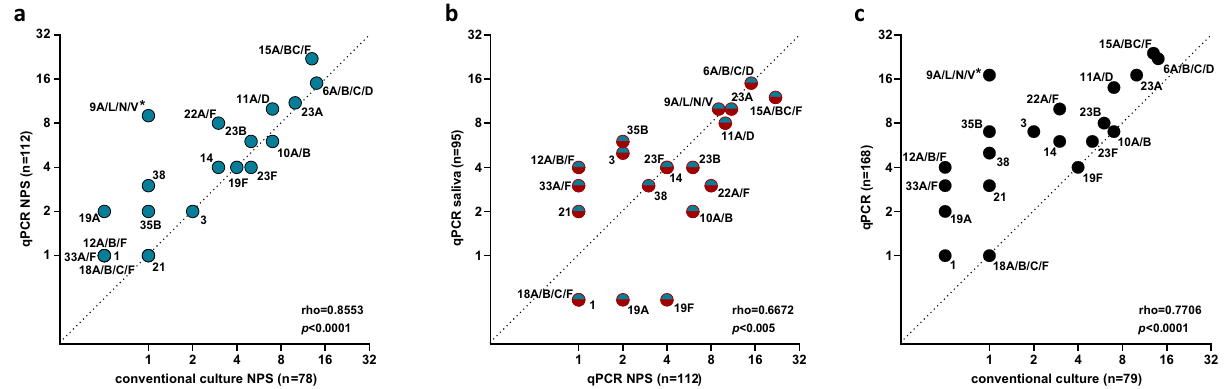
Figure 2. Scatter plot of results of pneumococcal serotypes detected by conventional culture and molecular method (qPCR). Panels ( a ) and ( c ) depict agreement between number of cultured (X-axis) and number of samples positive in qPCR among serotypes or serogroups targeted by qPCR assays. Panel ( a ) depicts results exclusively for NPS samples. Panel ( c ) depicts results for all strains cultured from NPS or saliva versus detected in NPS or saliva in qPCR assays. Panel ( b ) shows agreement between NPS (X-axis) and saliva (Y-axis) for serotypes detected exclusively with qPCR assays. Serotypes not detected using a given approach have been assigned a value of 0.5. The rho, and p values have been calculated with Spearman’s test. Asterisks depict significant differences in frequency of positive results between approaches compared * p < 0.05.